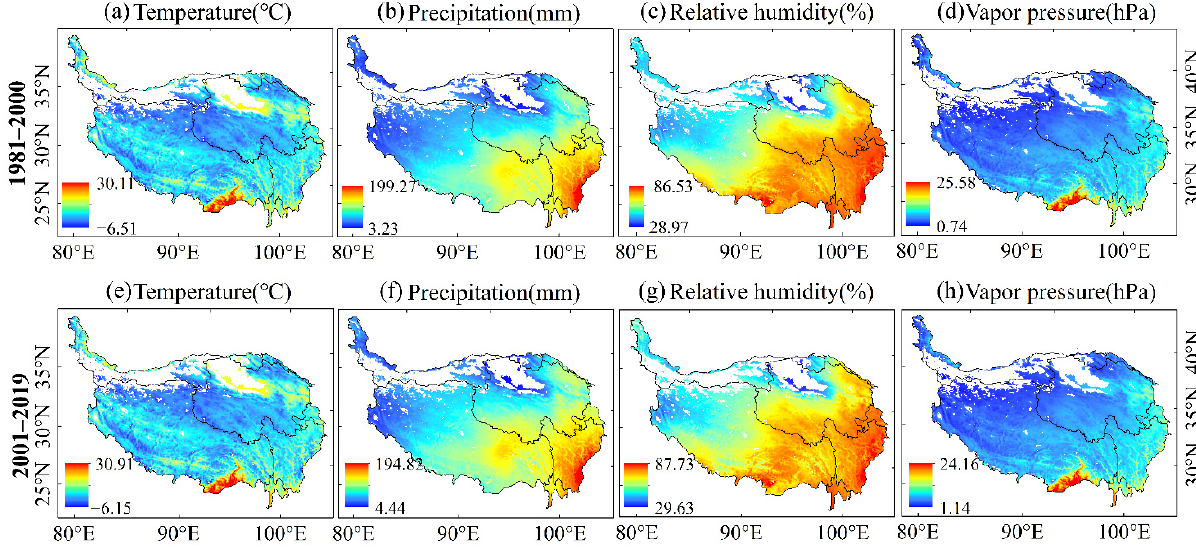
Figure 3. Spatial distribution of climatic variables in growing season during 1981–2000 and 2001–2019.